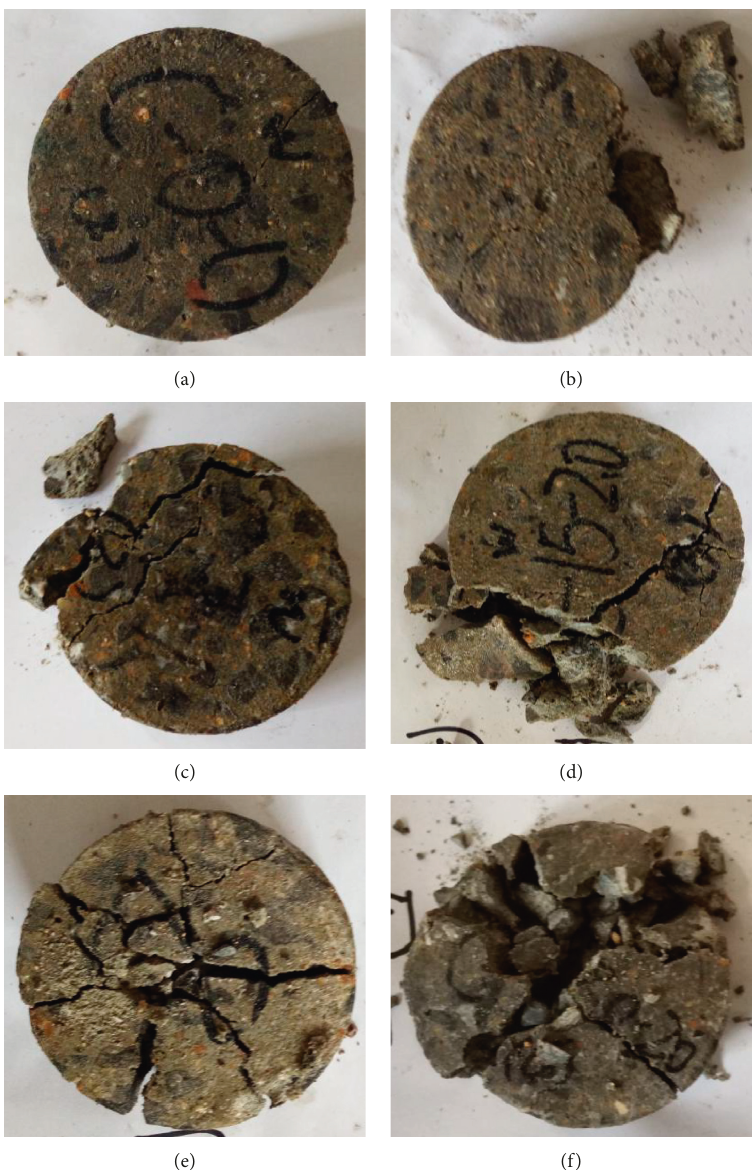
Figure 14: Failure modes of ready-mixed concrete in passive confining pressure state. (a) WC0-SP0. (b) WC2.0-SP3. (c) WC2.0-SP7. (d) WC2.0-SP15. (e) WC2.0-SP20. (f)